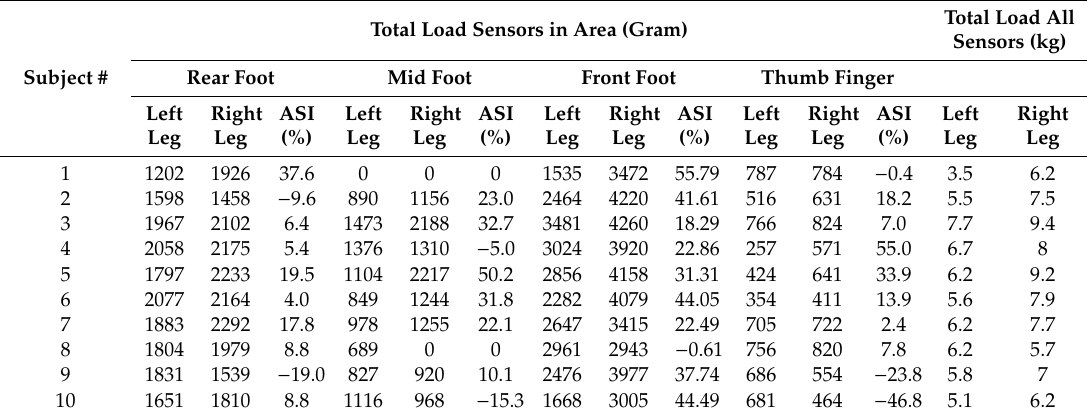
Table 5. The calculation of ASI (%) of each area of every subject.